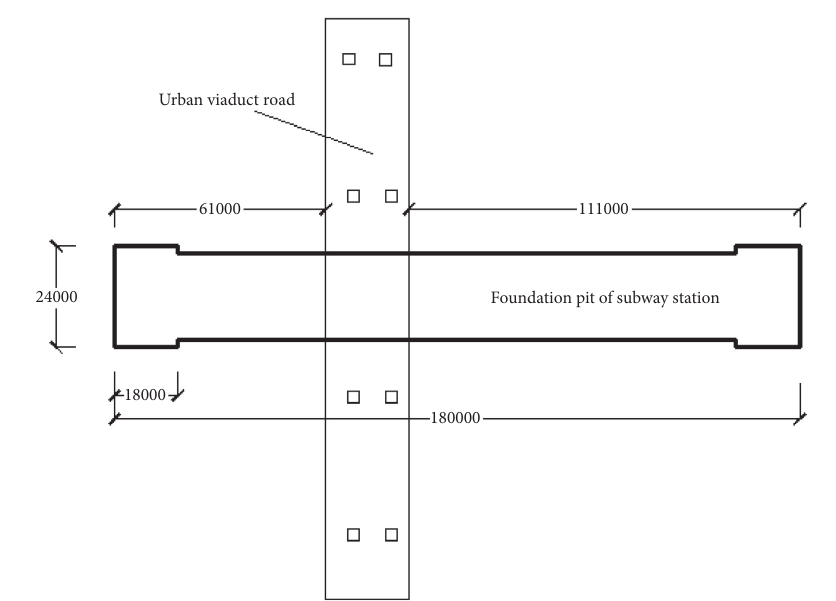
Figure 1: Relationship between the viaduct and subway station plane position.